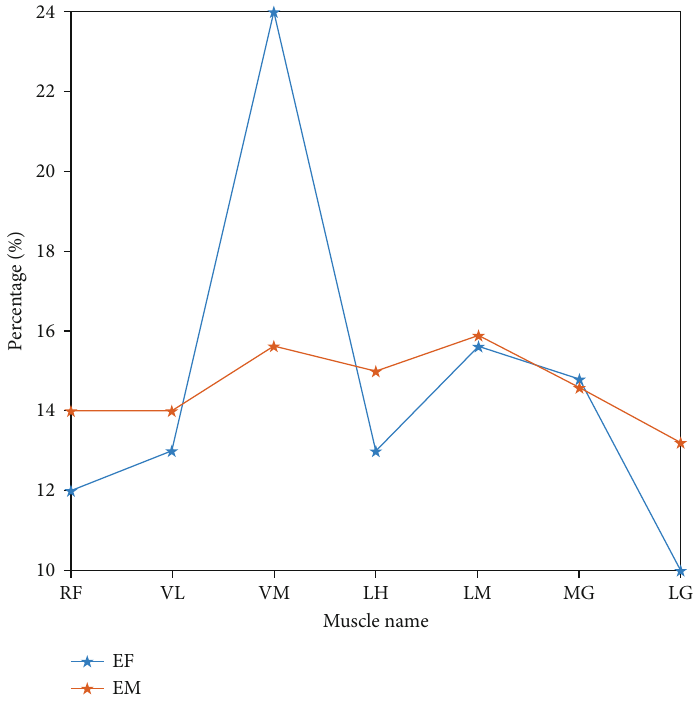
Figure 1: Comparison of muscle contribution rate between EF group and EM group.